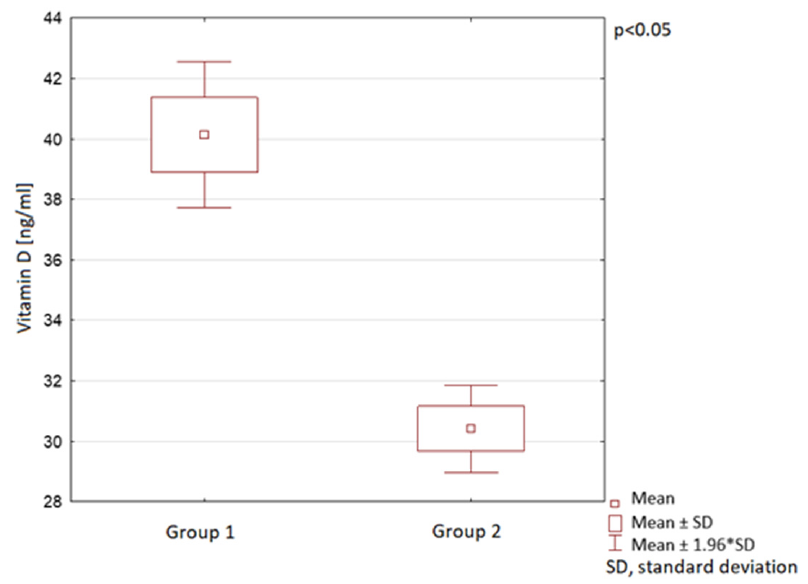
Figure 7. Vitamin D serum levels in summer in children in the compared groups. The characteristic seasonal variability was observed in Group 1, with maximal vitamin D levels in summer and minimal levels in winter (Figure 9). In Group 2, no seasonal variability was observed (Figure